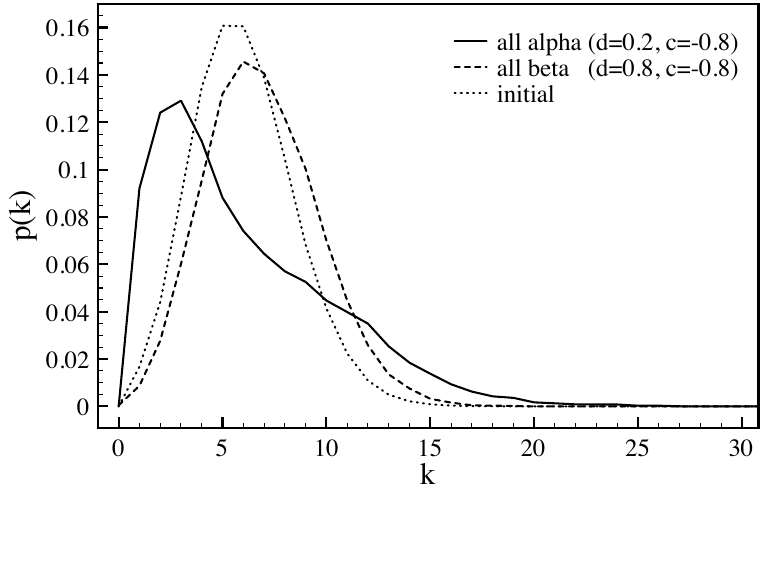
Figure 11. Average empirical degree distribution functions for the initial random graphs (dotted line), steady-state graphs in the α -dominant region of the parameters’ space (thick curve), and in the β -dominant region (dashed line) All distributions are discrete, continuous curves are just a guide for the